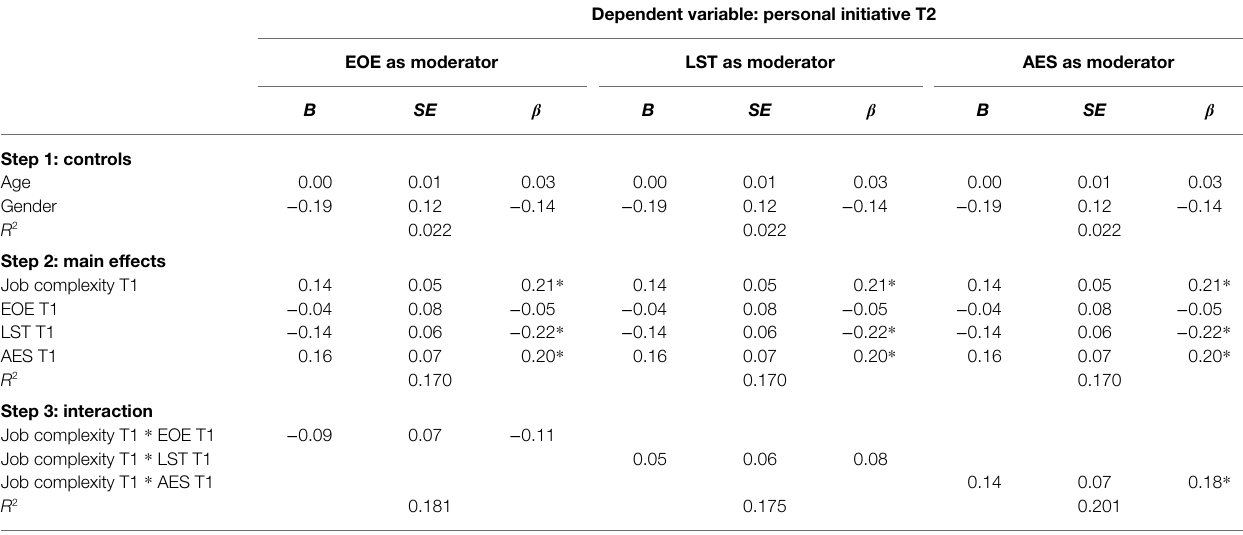
TABLE 6 | Results of hierarchical multiple regression analysis with personal initiative at T2 as dependent variable (Study